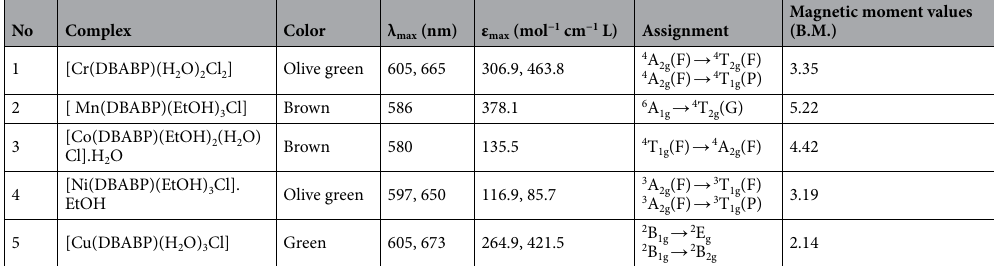
Table 4. Electronic absorption spectral data (in 10 –3 M DMF solution) and magnetic moment values of the metal complexes of the ligand, DBABP.